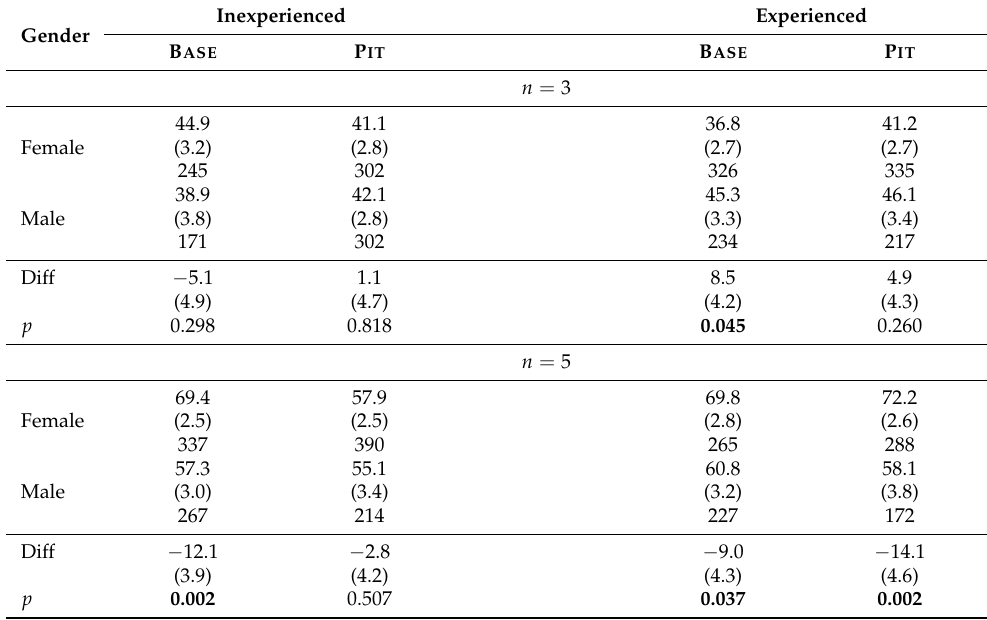
Table A8. Responder’s Probability to Vote “Yes” by Proposed Coalition Size, Experience, Treatment, and